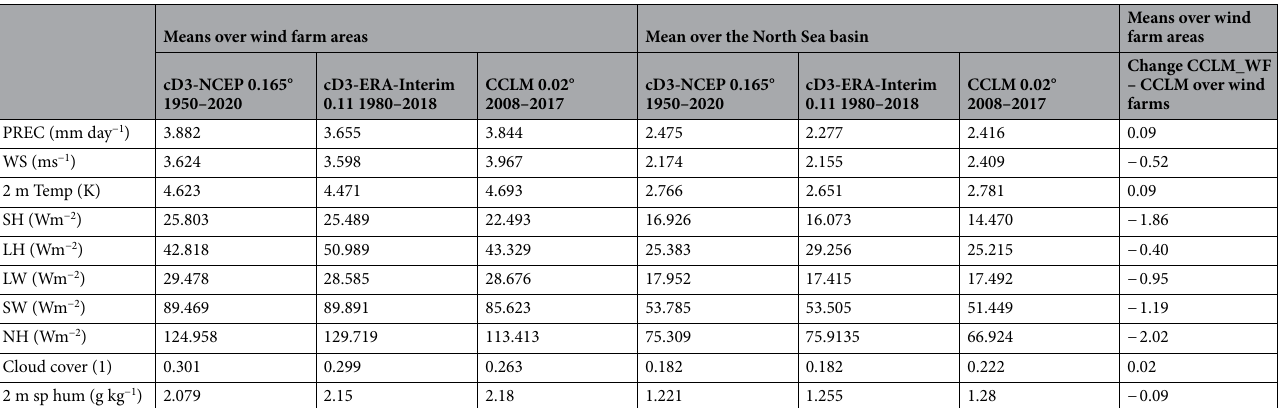
Table 1. Mean standard deviation per decade derived from regional reanalysis driven hindcasts (column 2—7), in comparison to the impact of wind farms (column 8).